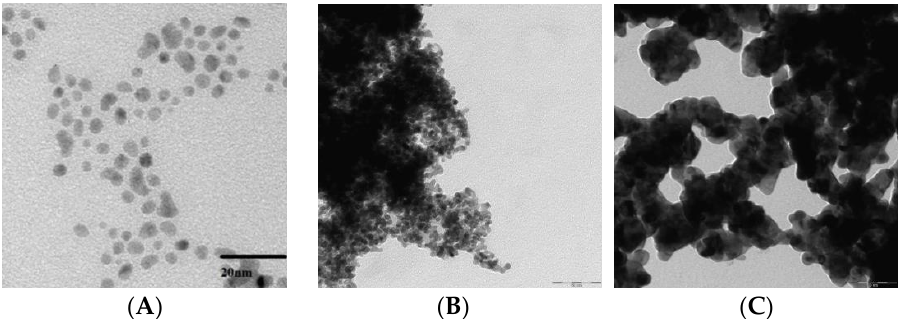
Figure 2. ( A ) TEM image of the PdNPs stabilized by 4-methylpyridine (PdNPs / 4MePy) from raw aqueous solution [51]. Pd: NaBH 4 molar ratio = 1:2, concentration of NaBH 4 solution = 1%. For synthesis conditions see Experimental Section. ( B ) TEM image of the PdNPs stabilized by 4-methylpyridine (PdNPs/4MePy) dried and re-suspended in distilled-deionized water. ( C ) TEM image of the PdNM (palladium-based nanostructural material) stabilized by 4-methylpyridine (PdNM/4MePy) obtained in ethanol.